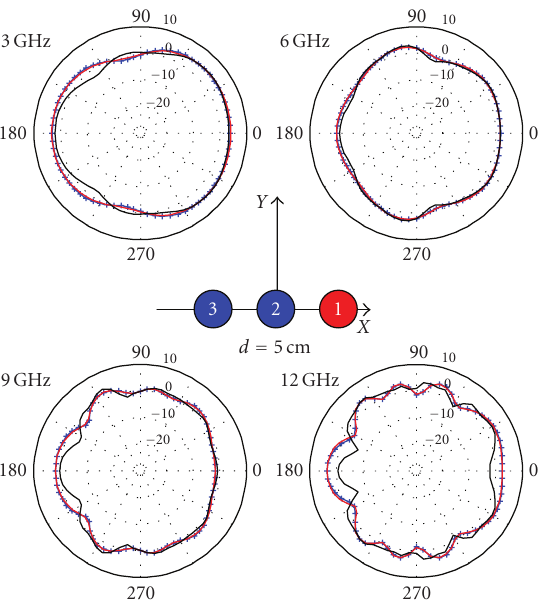
Figure 13: Three-bicone linear array ( d = 5cm) with feeding on antenna 1 and open circuit on antennas 2 and 3. Expected azimuth (X-Y plane) radiation pattern (black line), SC approximation with all single and multiple scattering terms (blue marker), and SC ap- proximation with only single scattering on antenna 2 (red